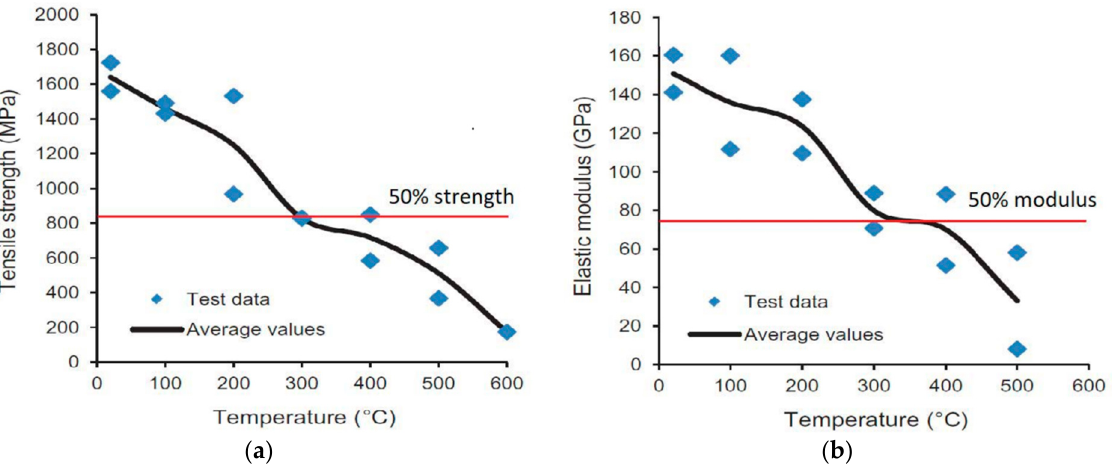
Figure 11. Variation of tensile strength and elastic modulus of CRFP strips with temperature. ( a ) Tensile strength; ( b ) Elastic modulus.